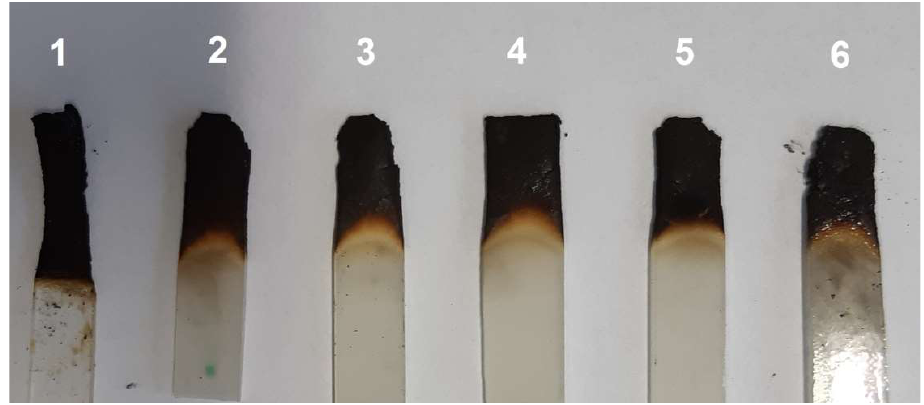
Figure 15. Samples after the burning test: sample 1—BPA.DM-NVP-0, sample 2—BPA.DM-NVP-1,